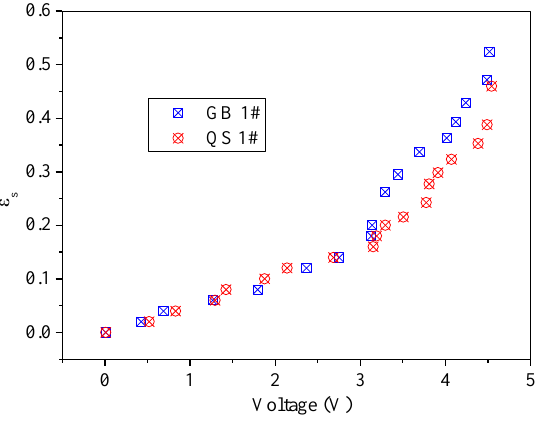
Figure 10. The compare of calibration results: GB1# and QS1#.